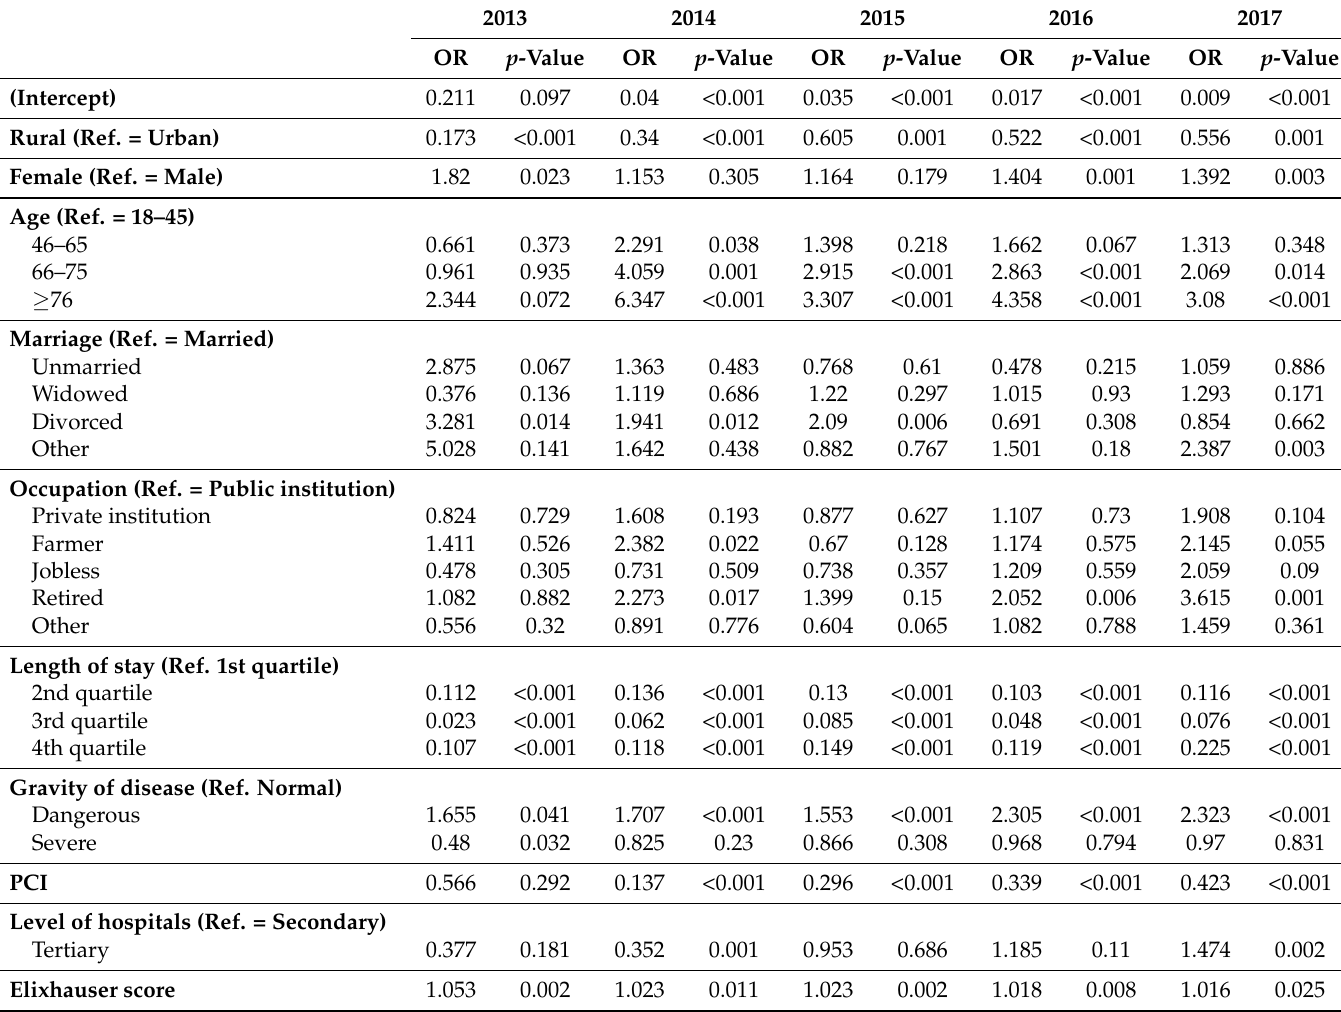
Table 2. Logistic regression results for in-hospital death,